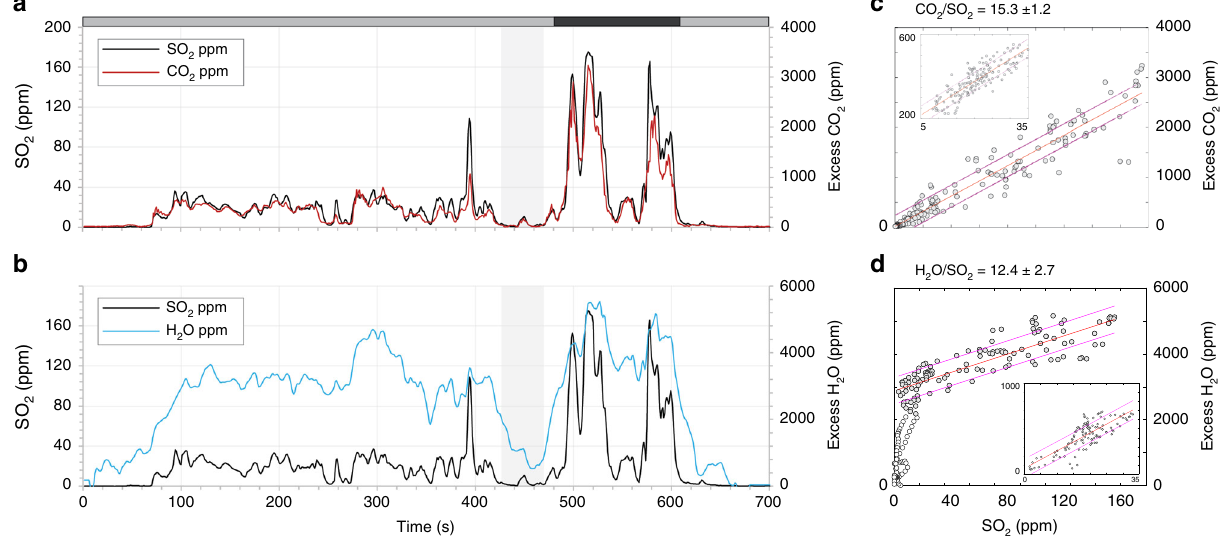
Fig. 5 Molar gas compositions for UAS over fl ight on 10/06/18. Molar gas composition data for an UAS over fl ight on 10/06/18 during passive degassing and a Strombolian explosion from vent N2, showing gas concentration timeseries for a SO 2 and CO 2 , b SO 2 and H 2 O. The shaded band at the top indicates passive (grey) and explosive (black) phases. Note the drop in magmatic gas concentrations to background immediately prior to the fi rst explosion (shaded column). c , d Scatterplots for the explosive phase emissions of SO 2 – CO 2 and SO 2 – H 2 O, respectively, displaying the least squares regression and 95% con fi dence intervals. Excess refers to the concentration of the gas species of interest above background, which was determined from clean air measurements made outside of the plume where SO 2 = 0. Gas molar ratios correspond to the gradient of the regression line shown. Note that for SO 2 – H 2 O, the regression is only based on SO 2 > 10 ppm due to the highly variable H 2 O at low SO 2 concentrations. Inset scatterplots show data for the passive degassing phase. See also Supplementary Fig. 2, for UAS over fl ight on 10/06/18 during passive degassing and a Strombolian explosion from vent